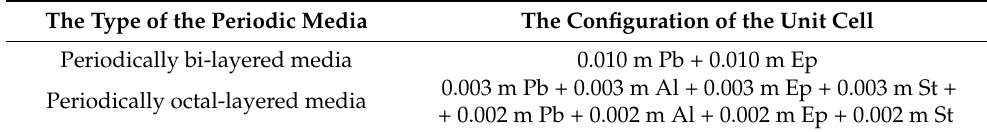
Table 2. The constitution of the exemplified periodically multilayered isotropic